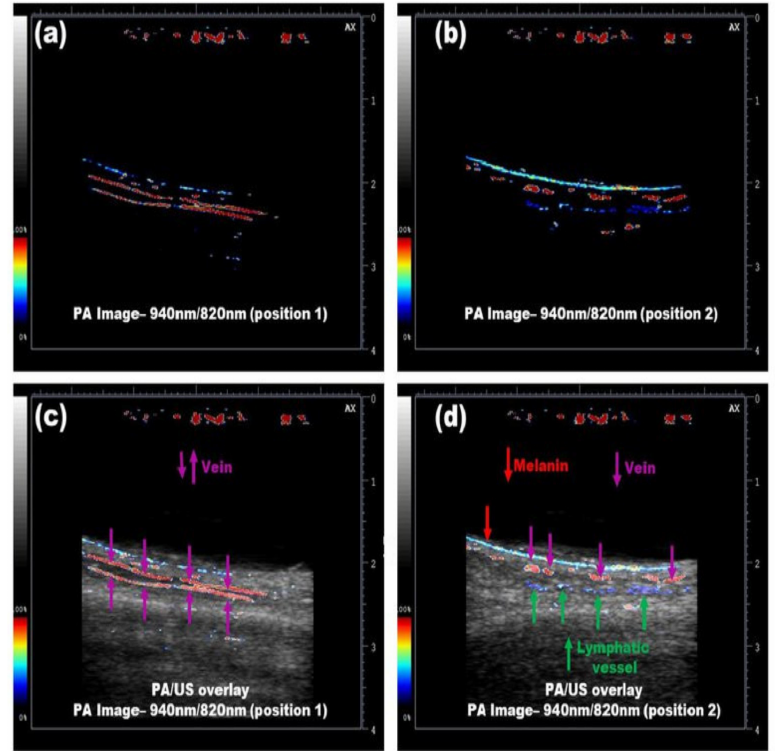
Figure 12. Real-time imaging of lymphatic vessels and veins simultaneously using LED-based PAI. ( a ) PA image: 940 nm / 820 nm image generated when the probe was aligned to a vein (position 1); ( b ) PA image: 940 nm / 820 nm image generated when the probe was aligned to a lymphatic vessel (position 2); ( c ) 940 nm / 820 nm PA image overlaid on US image when the probe was in position 1; and ( d ) 940 nm / 820 nm PA image overlaid on US image when the probe was aligned to position 2. Reprinted from Ref.